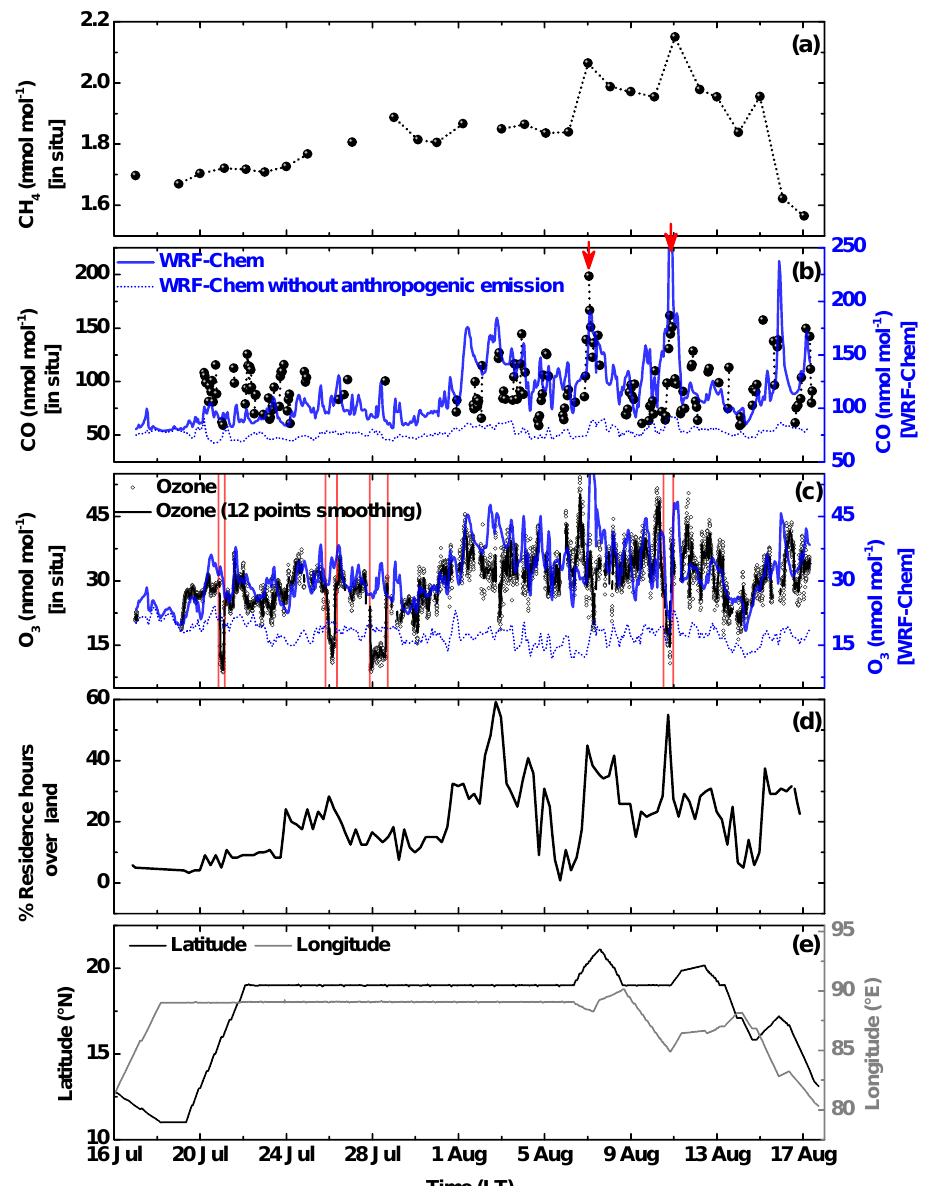
Figure 4. Variations in observed CH 4 (a) , CO (b) , O 3 (c) , and percentage residence time over land (d) along with WRF-Chem simulated O 3 and CO (blue line) during the campaign. Events of sharp decrease in O 3 during rainfall are marked by vertical red lines (Fig. 8). (e) Variations in measurement